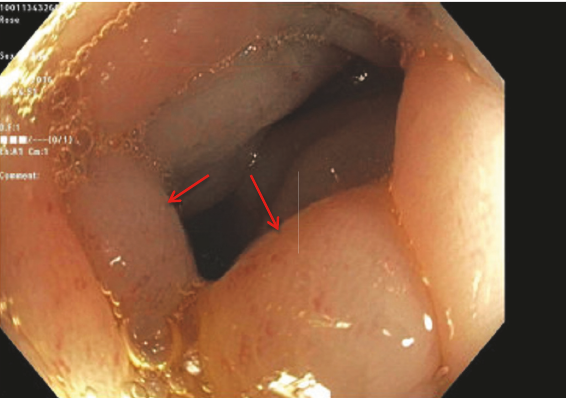
Figure 5: Pneumatosis coli of the sigmoid colon